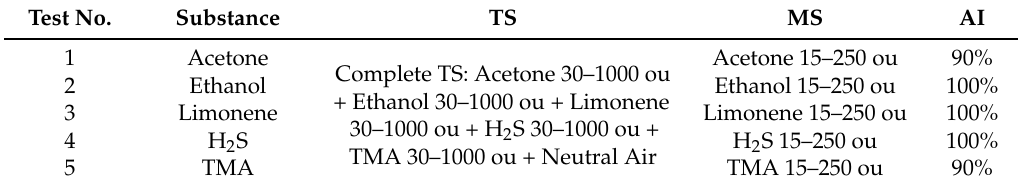
Table 7. Scheme and results of the tests for the evaluation of the classification accuracy. Test